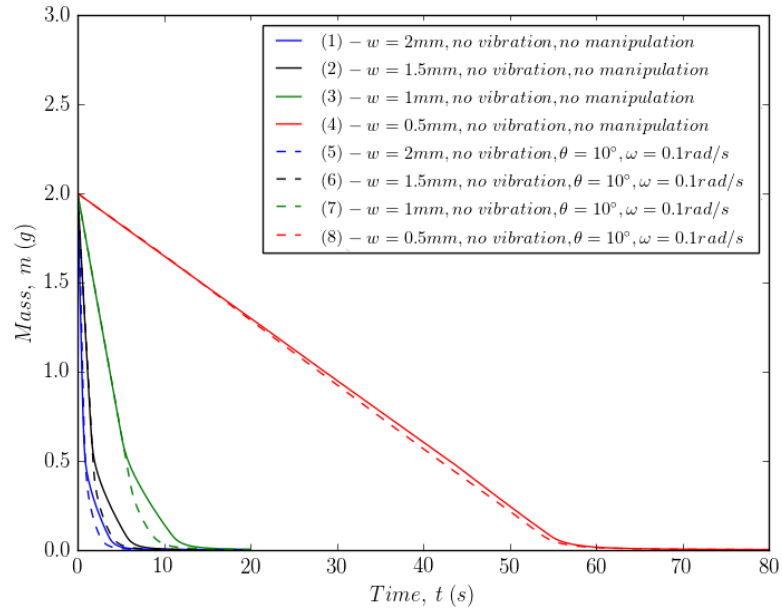
Figure 9. Effect of manipulation sequence.